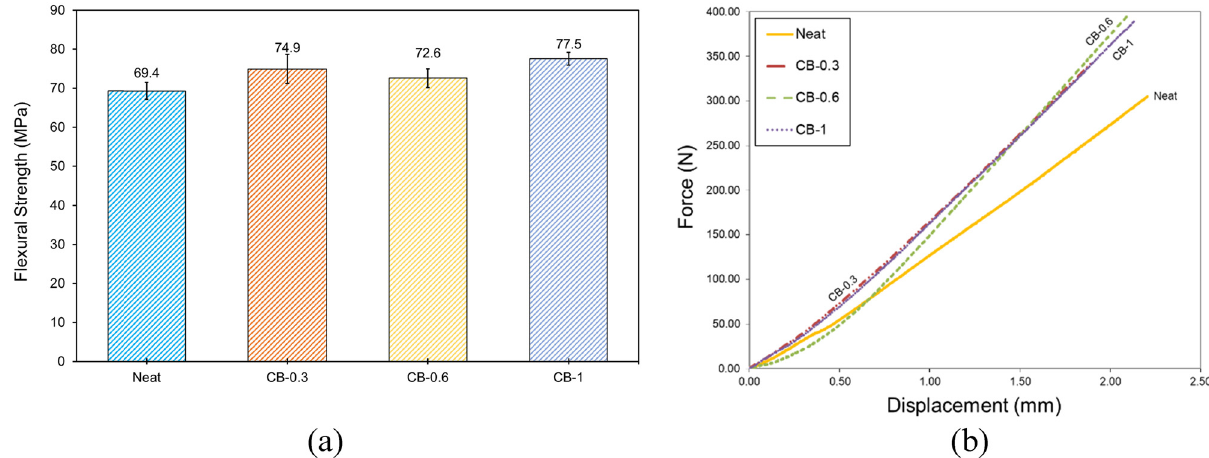
Figure 5: ( a ) Average bending strengths of the samples and ( b ) force – displacement curves of the